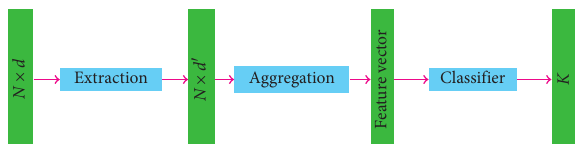
Figure 1: A typical framework of a 3D point cloud classification process. The model takes N points in d -dimensional space as its input and then extracts point features of dimension d ′ , followed by an aggregation module used to form a feature vector which is invariant to point permutation. Finally, a classifier is used to classify the resulting feature vector into K